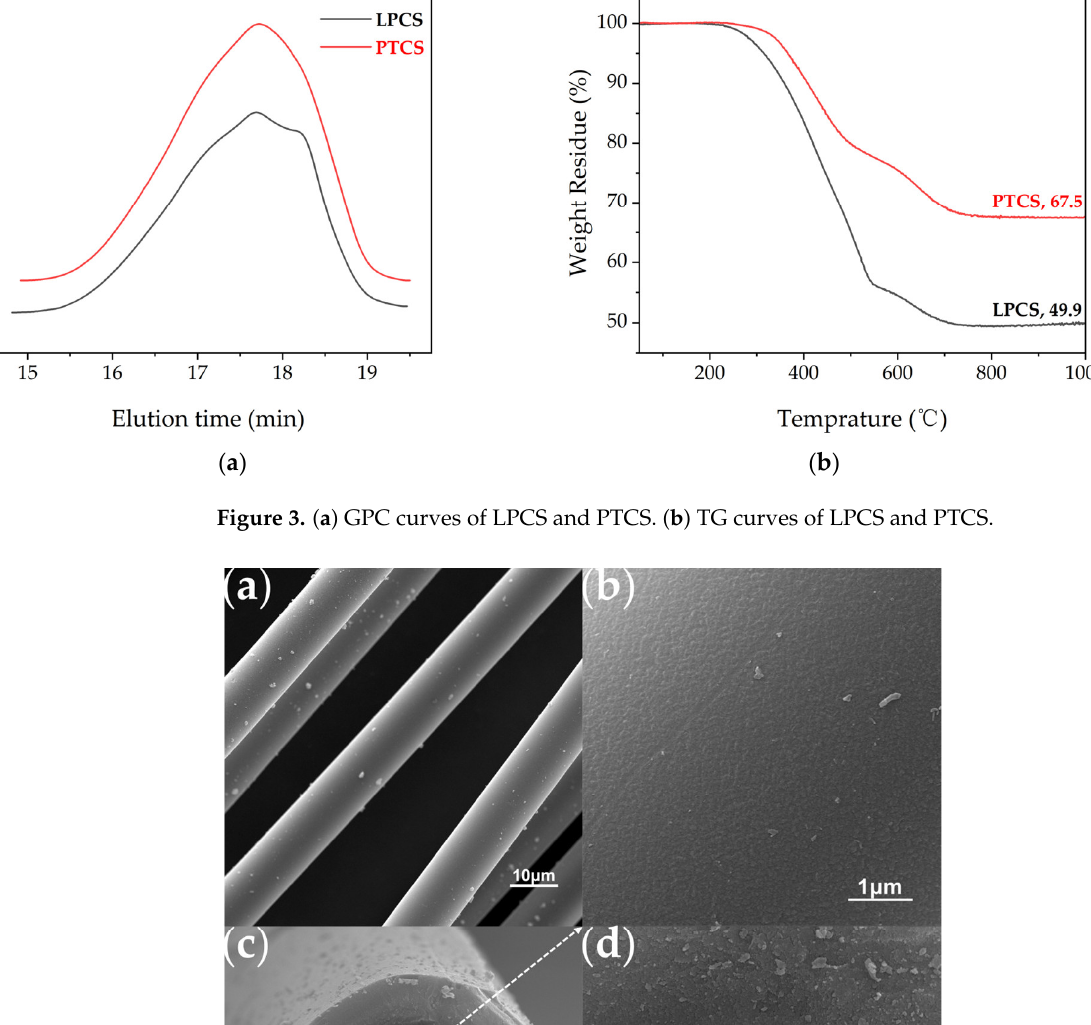
surface. Figure 4c,d show that the core of the Si–C–O–Ti–B fibers cross–section is relatively loose and contains a small number of micropores, while the areas closer to the edge of the fiber cross–section are denser. In addition, it can be observed that there is a less–apparent carbon–rich layer on the surface of the Si–C–O–Ti–B fibers. From Figure 5, it can be seen that the diffraction peaks of Si–C–O–Ti–B fibers are not very sharp, indicating that the Si–C–O–Ti–B fibers are not completely crystallized and still retain some amorphous phases. The characteristic diffraction peaks of the (110) crystal plane of SiO 2 appear near 2 θ = 20.9 ◦ , and the (111), (220) and (311) crystal plane of β –SiC appear near 2 θ = 35.4 ◦ , 60.3 ◦ and 71.7 ◦ , respectively. In addition, the average tensile strength of the fiber is 1.72 GPa.